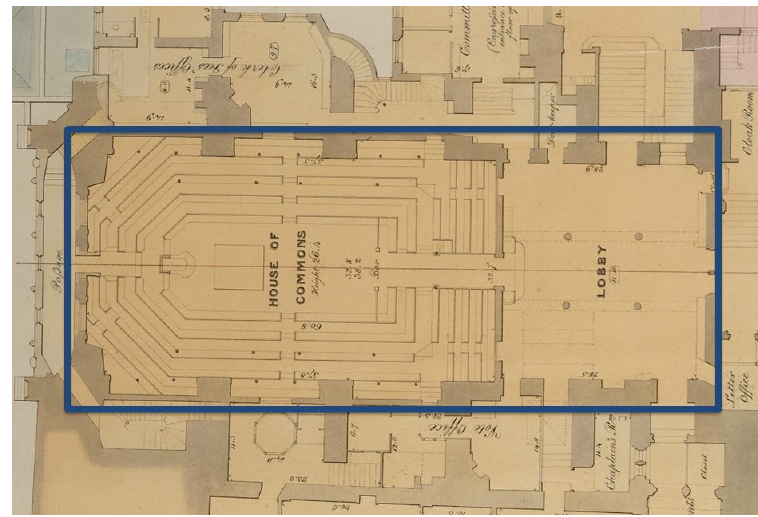
Figure 1. Detail from the architectural plans of the pre-fire House of Commons, as seen at [3]. The blue frame highlights the original boundaries of the medieval chapel of St Stephen, which was then separated into the House of Commons (east) and the Lobby (west).